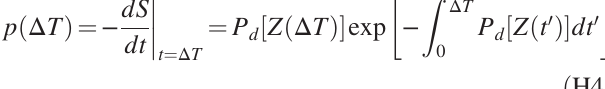
FIG. 11. (a) The variance versus mean of the fluorescence density, both in arbitrary units (arb. units), from the experiments reported in Ref. [25]. The dashed line is obtained using an average value for the coefficient A ¼ σ 2 h A i ¼ 0 . 12 . (b) The scaled protein concentration distributions from the experimental data reported in Ref. [25]. The black curve is the distribution that we show in the main text.